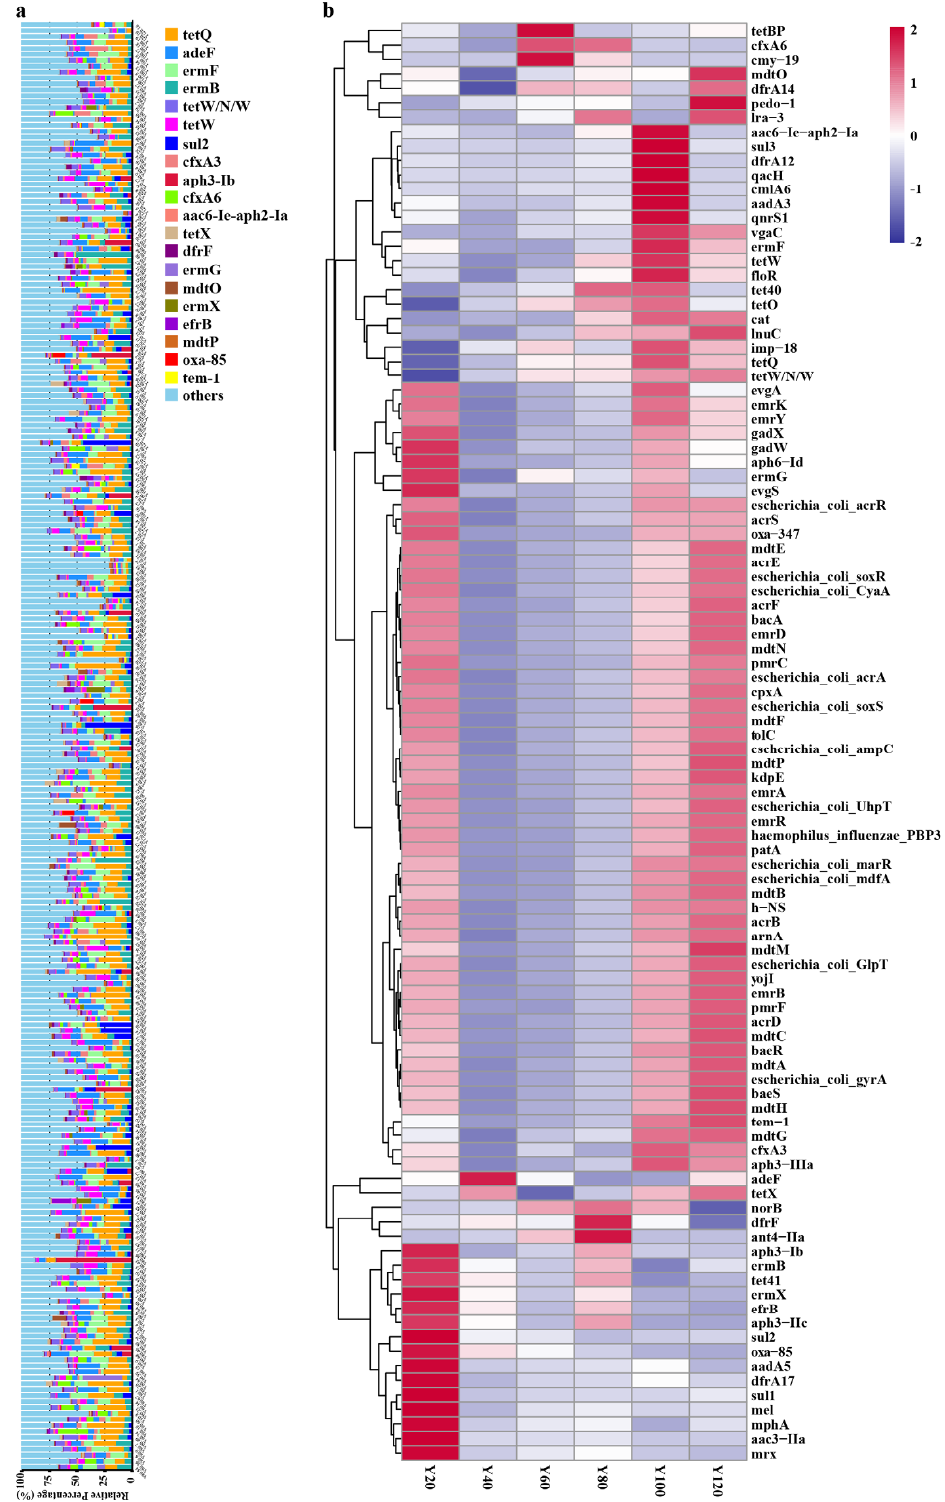
Figure 2. Comparative analysis of ARG in different age groups. ( a ) comparison of the top 20 most abundant ARG types in differently-aged individuals; ( b ) comparison of the top 100 most abundant ARG types in the different age groups.